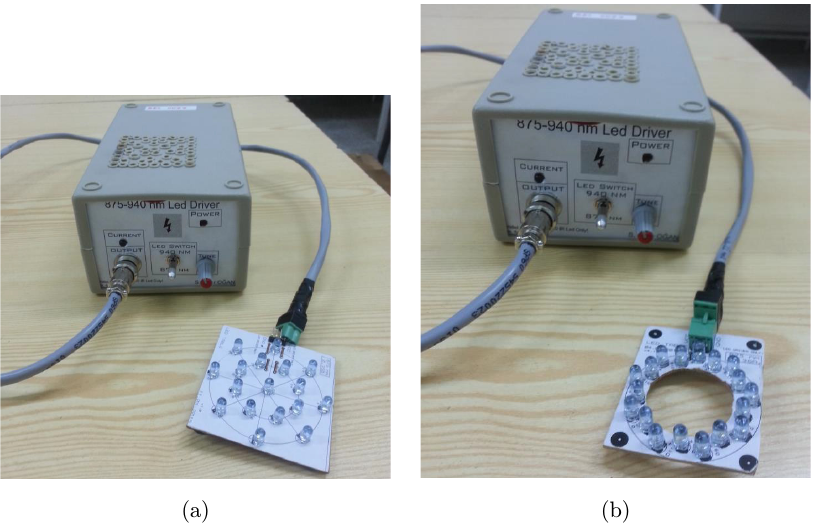
Fig. 2. LED light source device and LED layoults; (a) Disk shaped design and (b) Ring shaped